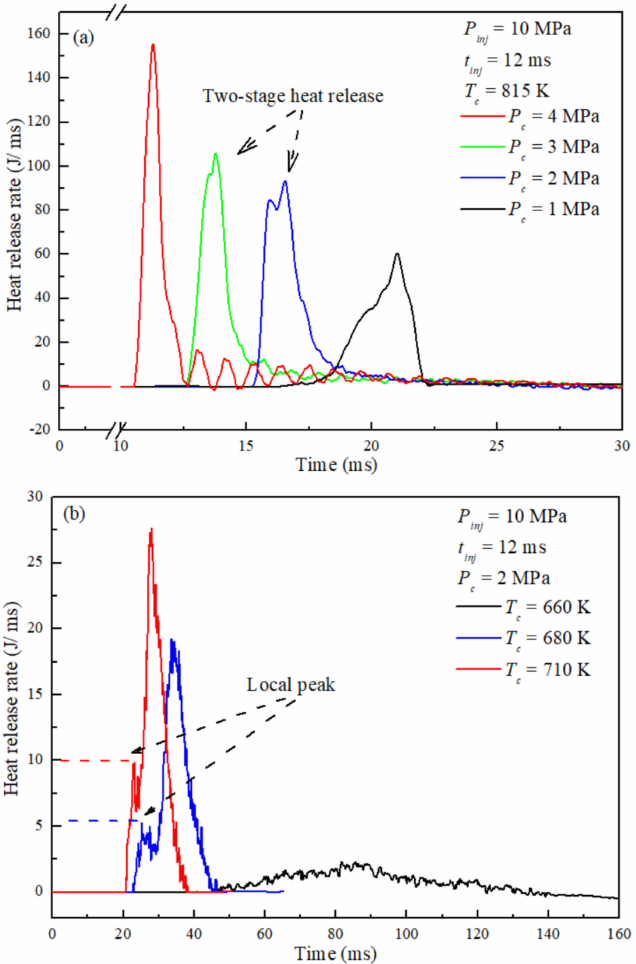
Figure 10. Heat release rate histories of tests under different EOC pressures ( a ) and EOC temperatures ( b